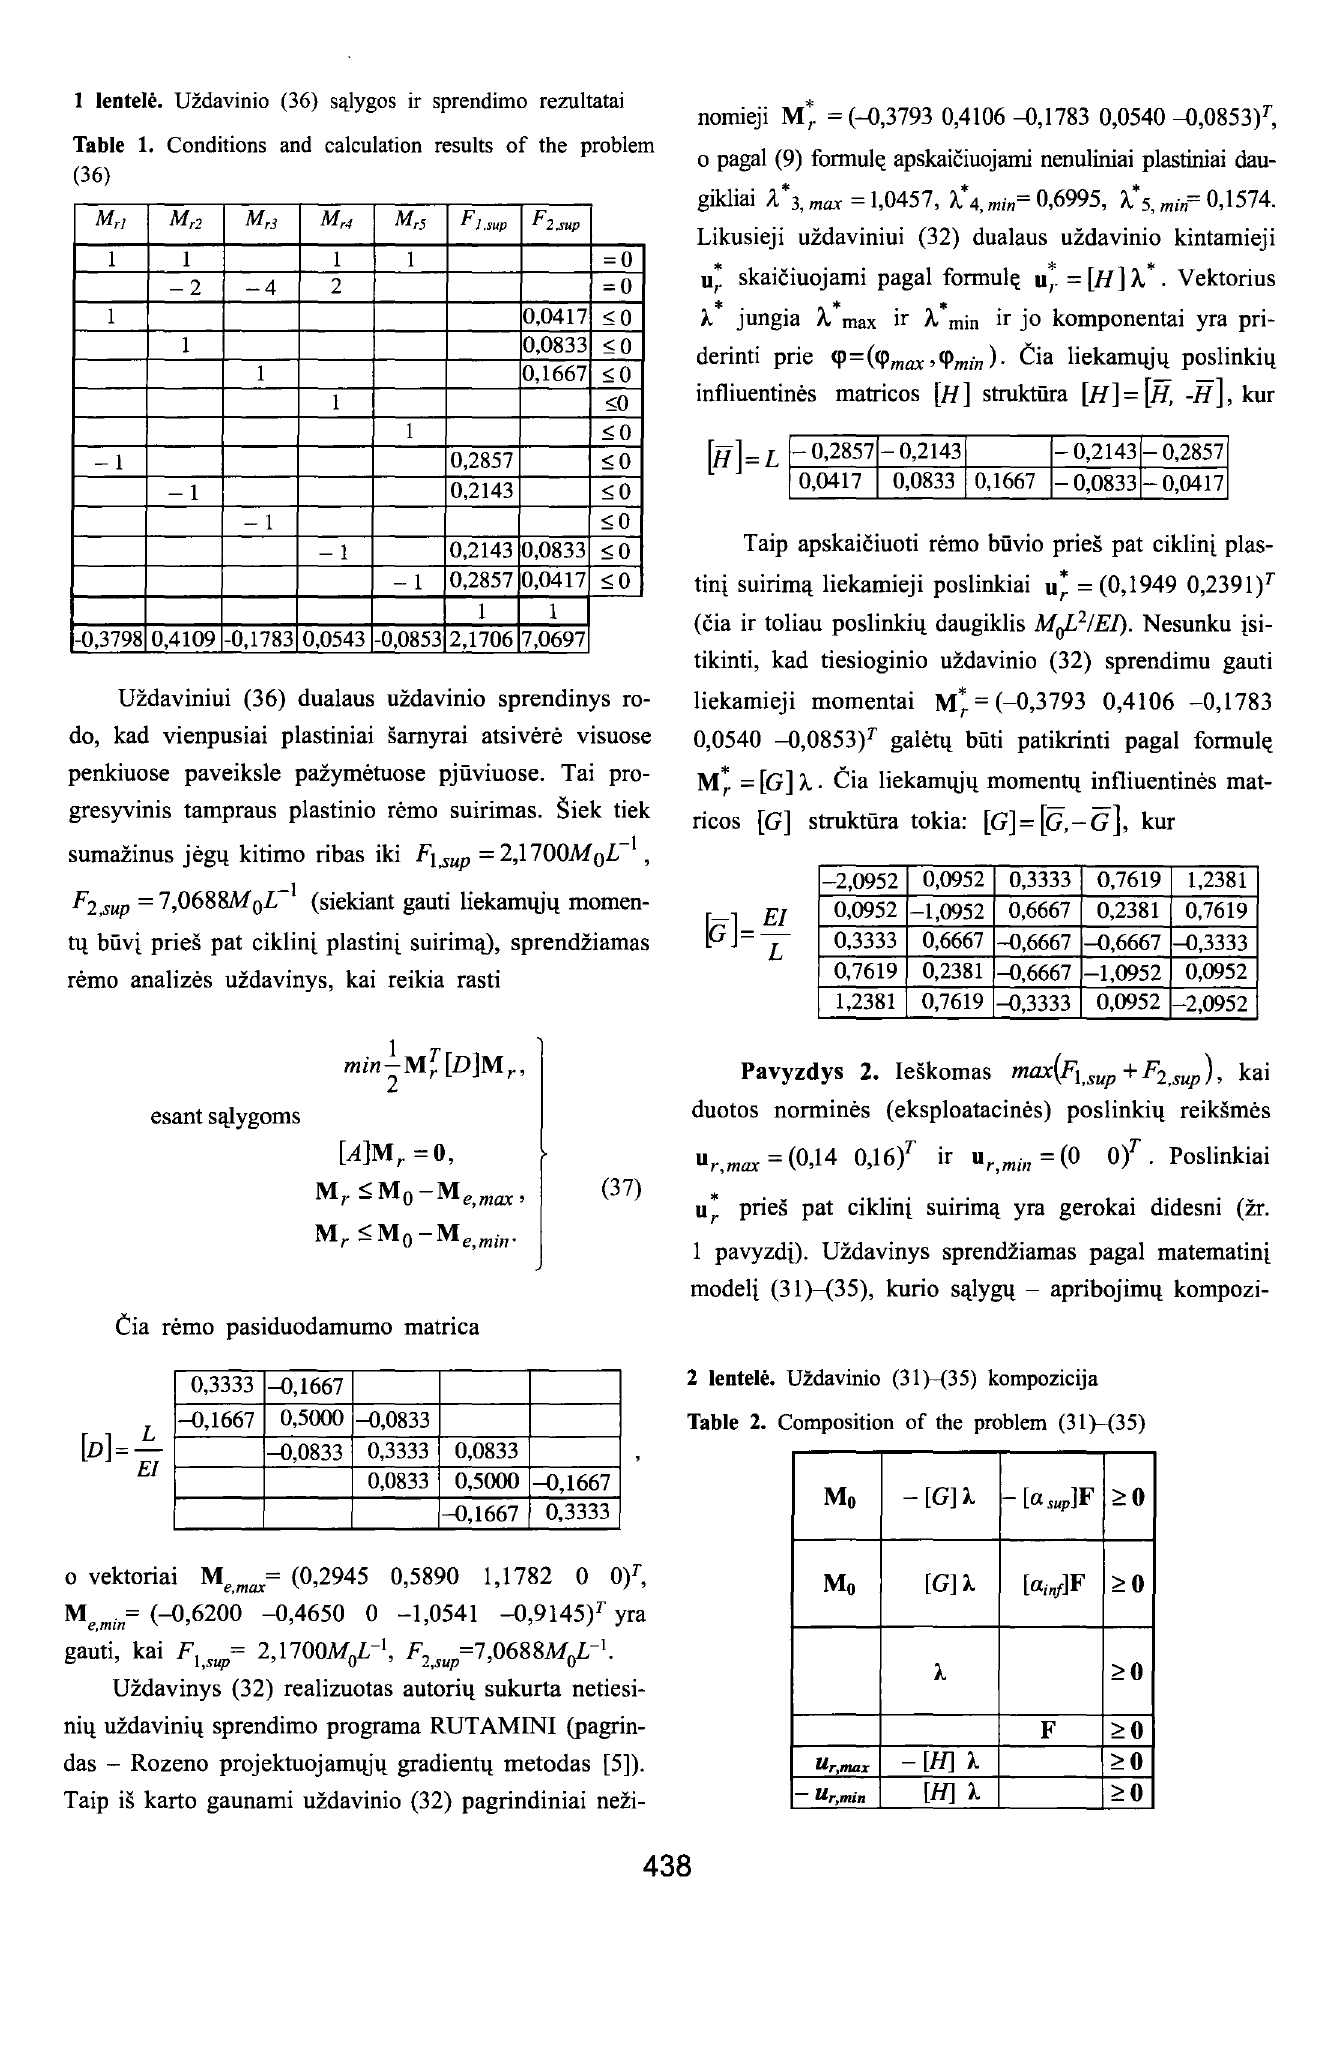
Table 2. Composition of the problem (31